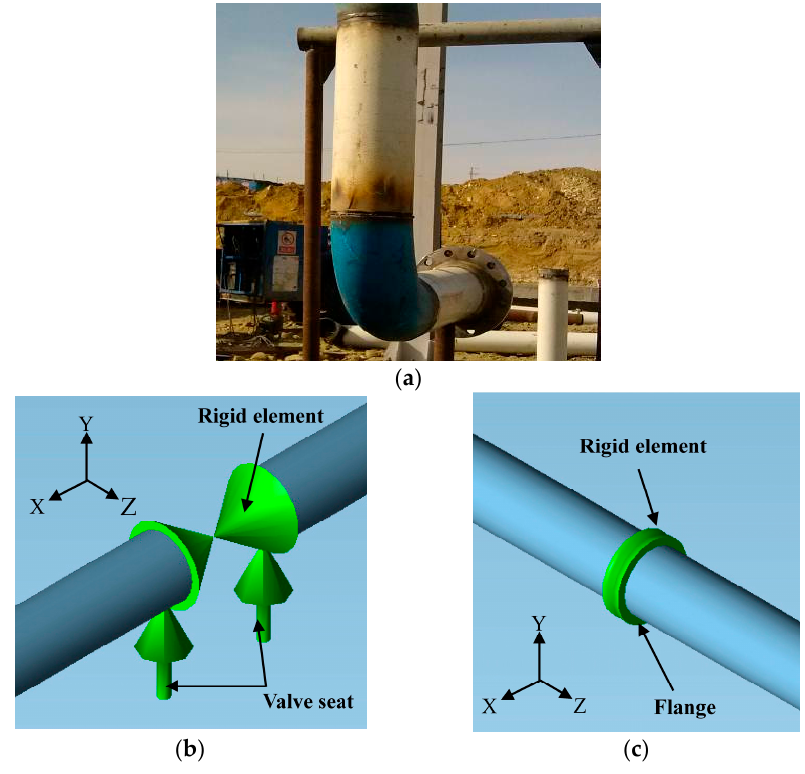
Figure 15. Rigid element: ( a ) physical map of flange; ( b ) numerical simulation model of valve in CAESAR II software; ( c ) numerical simulation model of flange in CAESAR II software.